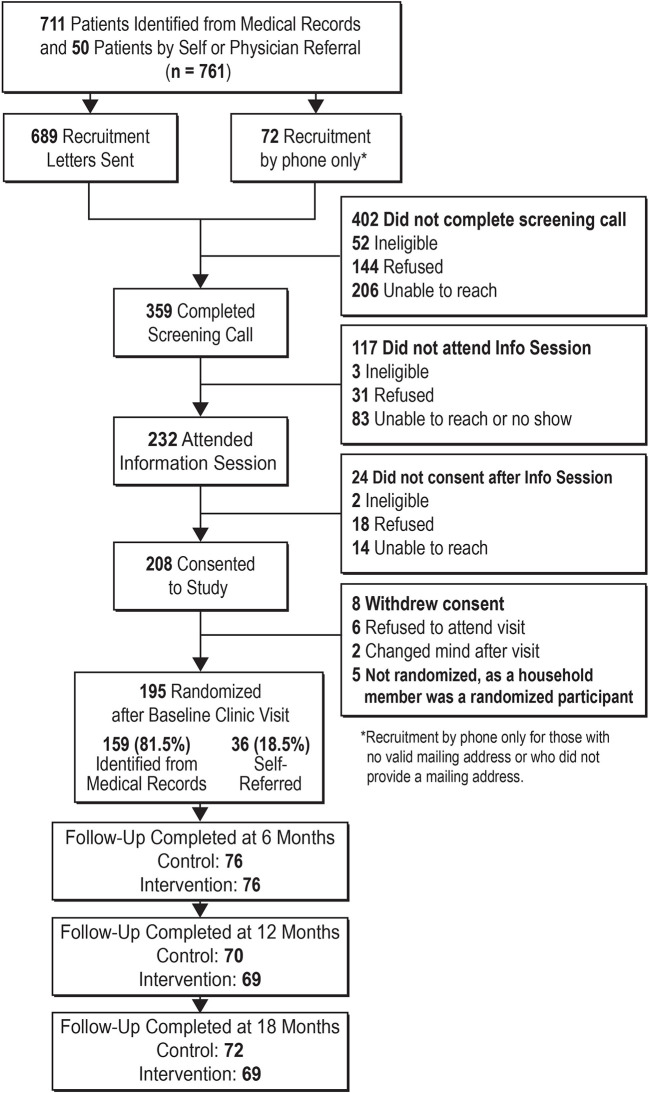
Consort diagram.